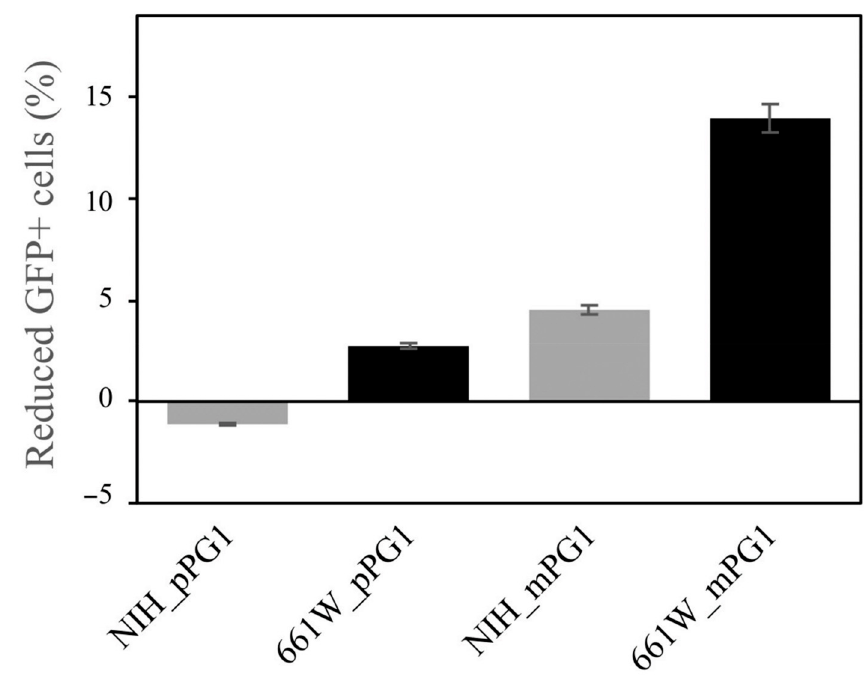
Figure 4. Changes in the viability of cells after PG1 expression. EGFP-tagged preproPG1 (pPG1) and mature PG1 (mPG1) were separately transfected into NIH3T3 and 661W cells. The number of EGFP-positive cells was measured 16 h after transfection. mPG1 -transfected cells showed a significant decrease in the number of EGFP-positive cells compared to that of pPG1.